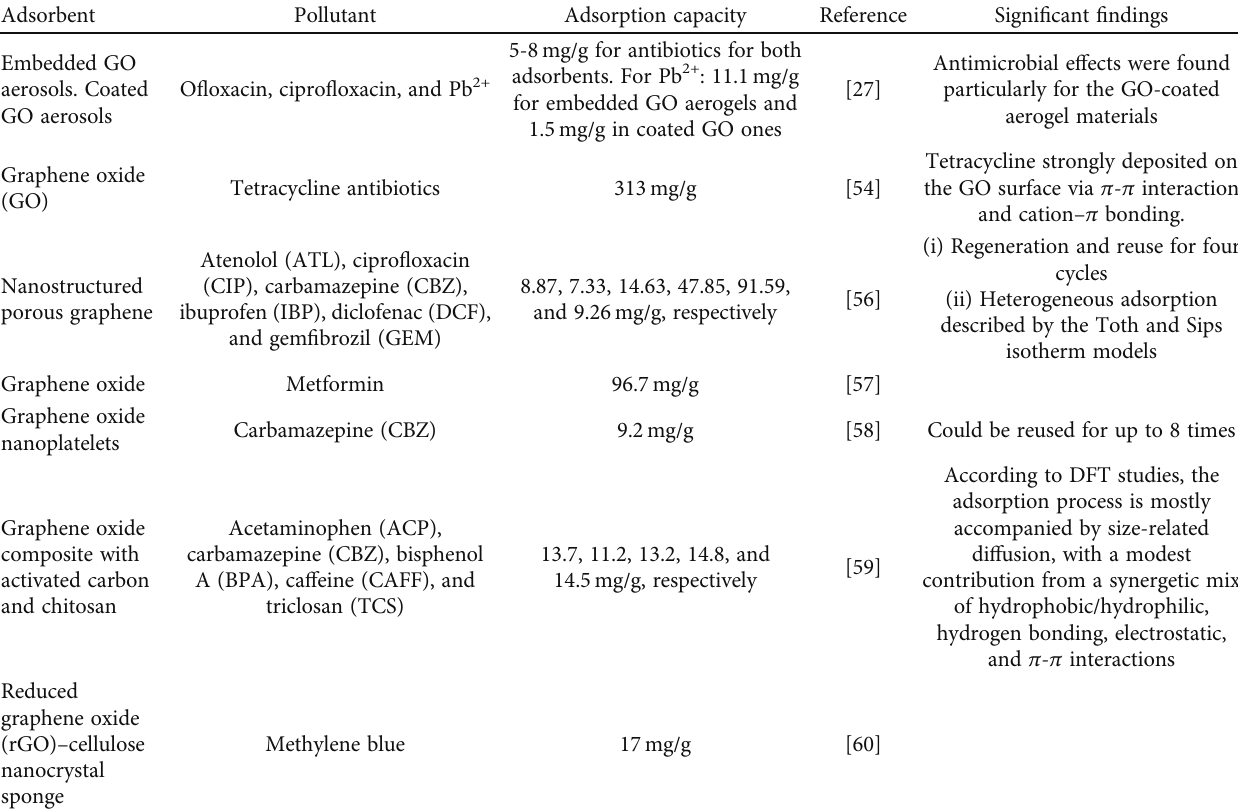
Table 2: Removal of emerging contaminants by GO-based